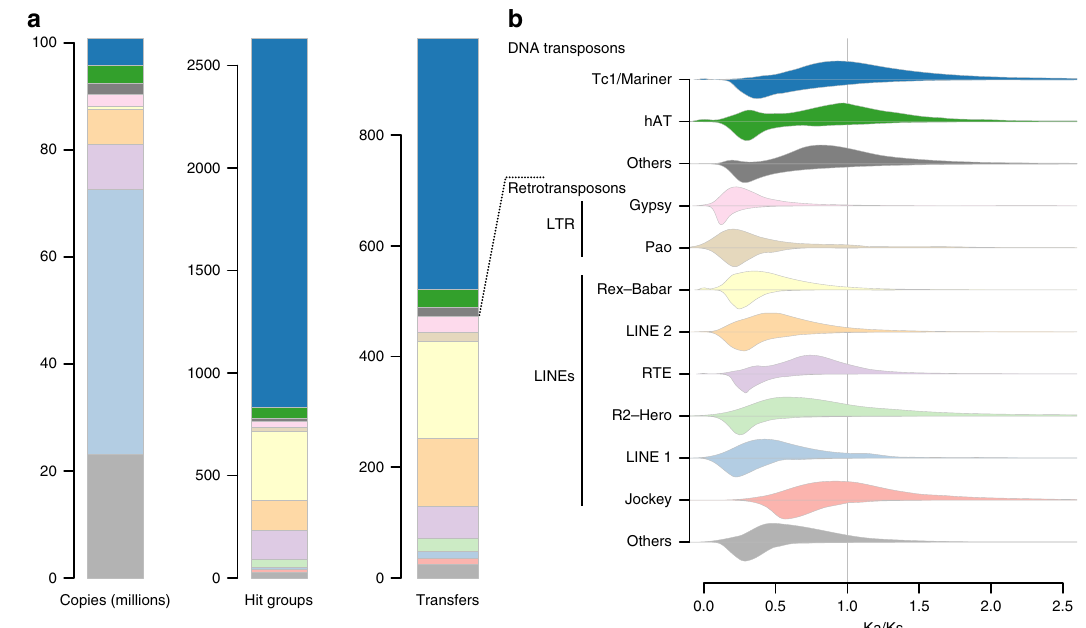
Fig. 4 TEs superfamilies involved in horizontal transfer among the 307 studied vertebrate genomes. a Statistics on TEs superfamilies. Numbers of TE copies only consider those of at least 300 bp. “ Hit groups ” represent horizontal transfer events that may either be direct or indirect (see text). “ Transfers ” represent the minimal numbers of HTT events required to explain the data. Superfamilies are shown in the same colors as in ( b ). b Distributions of Ka/Ks ratios between TEs. For each TE superfamily, the upper curve shows the distribution of Ka/Ks ratios between TEs that diverged through transposition within genomes, and the lower curve represents Ka/Ks ratios between TEs that partly diverged through HTT (i.e., that belong to the different vertebrate clades involved in a transfer). Ka/Ks ratios are signi fi cantly lower than 1 for all distributions ( p < 1%, one-sided Mann – Whitney U -tests, Supplementary Table 2), except for those of DNA transposons and Jockey retrotransposons that diverged through transposition